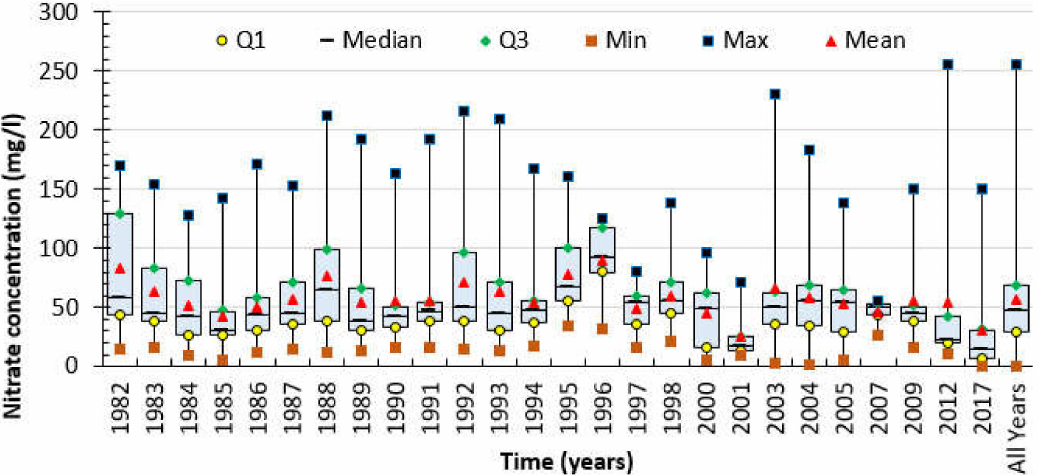
Figure 3. Statistics of the annual nitrate concentrations in the Eocene aquifer for specific years between 1982 and 2017 (based on the database of the Palestinian Water